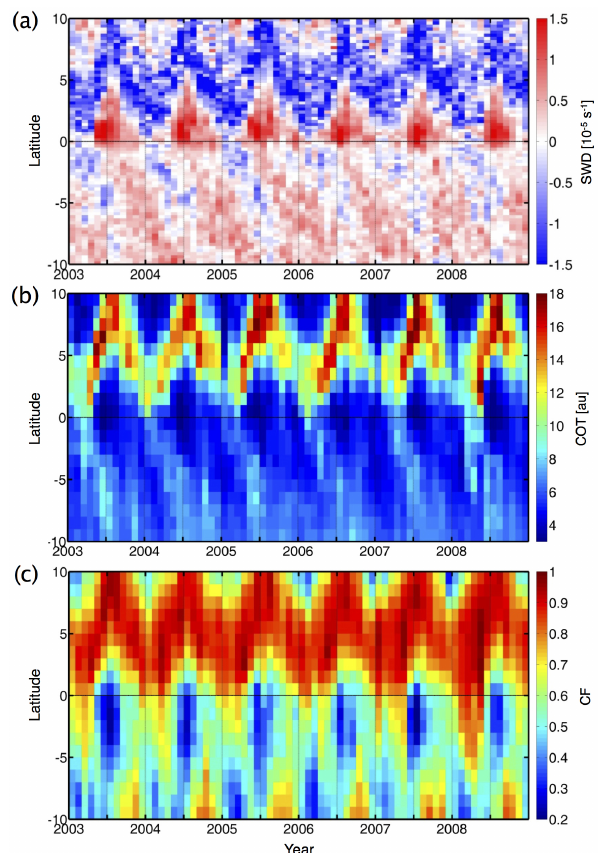
Figure 5. Latitude–time Hovmöller diagrams (2003–2008) of zonal and monthly mean (a) surface wind divergence (10 − 5 s − 1 ), (b) cloud optical thickness, and (c) cloud fraction. The central At- lantic section (20–10 ◦ W) averaged for these Hovmöller diagrams is in the yellow square in Fig.